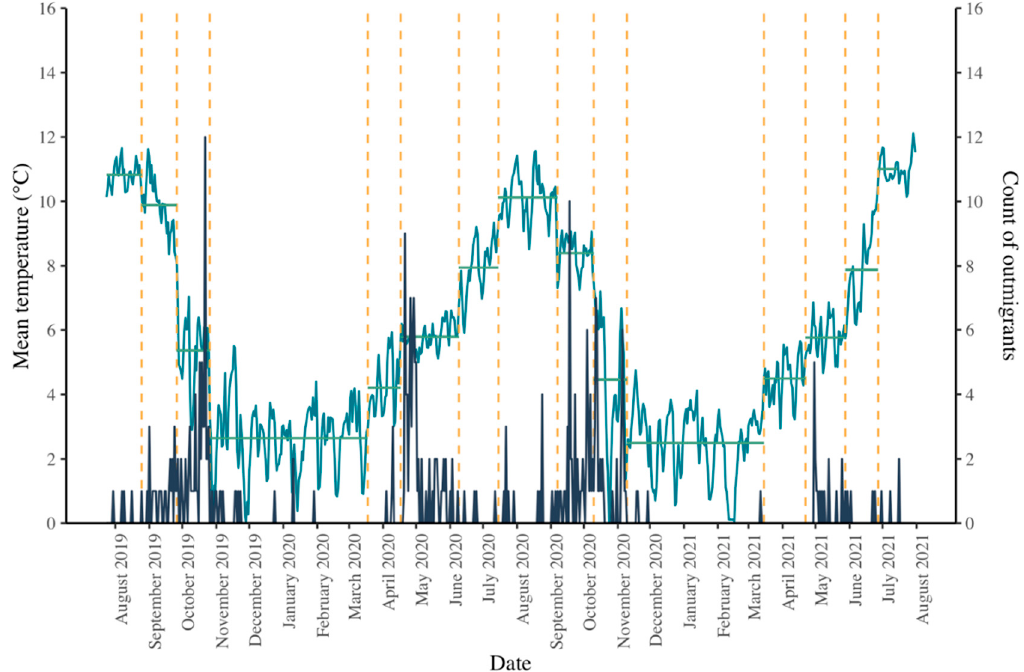
Figure 7. Time series from Graves Creek, Montana, from 25 July 2019 through 1 August 2021, with the light blue line delineating time series of mean daily water temperature (°C) and the dark blue line delineating time series of bull trout out-migrating by day. Dotted yellow lines delineate changepoints, and horizontal green lines represent the mean for each segment between the changepoints.